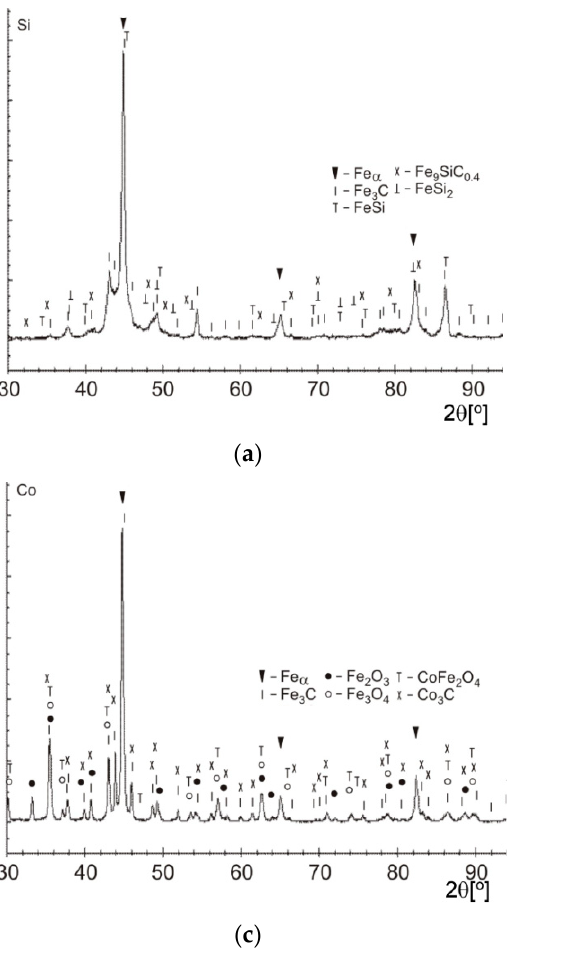
Figure 17. X-ray diffraction of nodular cast iron surface layer, after laser alloying with: ( a ) silicone; ( b ) silicon nitride; ( c ) cobalt; and ( d ) titanium.